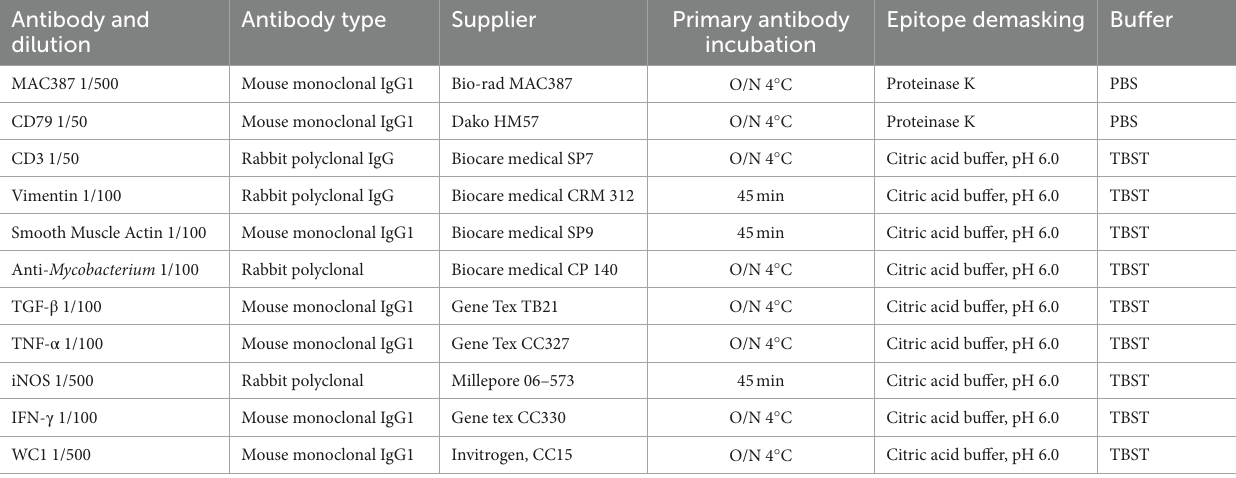
TABLE 1 Immunohistochemical reagents and technical